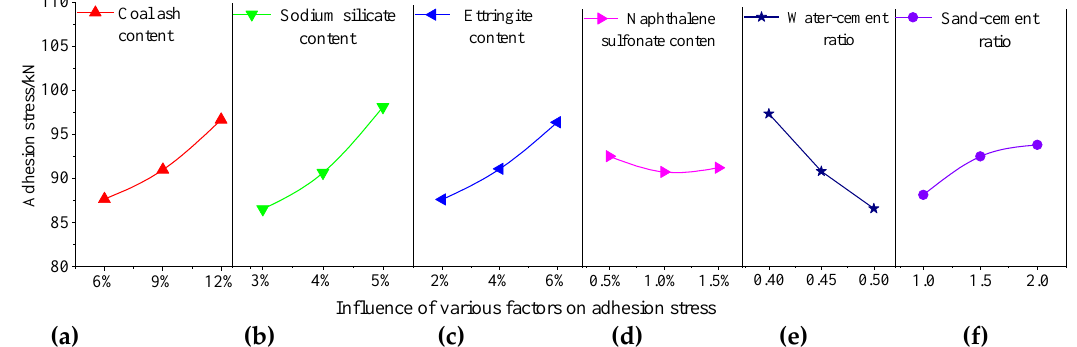
Figure 11. Trend diagram of the effect of various factors on the adhesion stress. ( a ) coal ash content; ( b ) sodium silicate content; ( c ) ettringite content; ( d ) naphthalene sulfonate content; ( e ) water – cement ratio; and ( f ) sand – cement ratio.